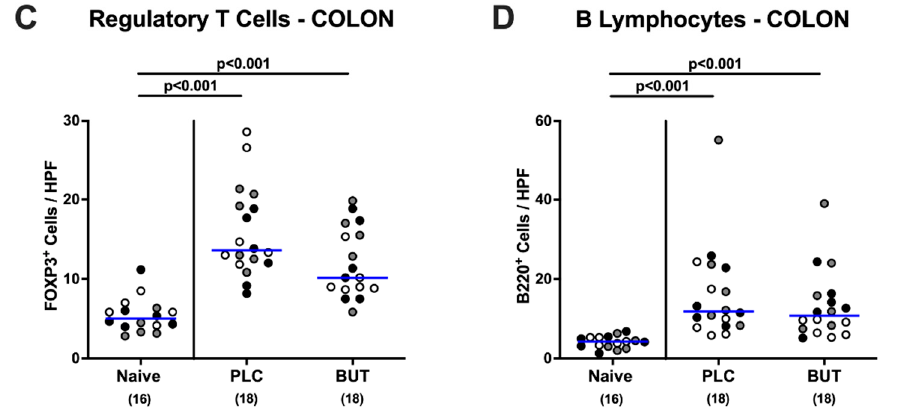
Figure 5. Immune cell populations in the colon upon butyrate treatment of C. jejuni mice. Following gut microbiota depletion IL-10 − / − mice were challenged with C. jejuni strain 81–176 by oral gavage on days 0 and 1. Starting from day 2 p.i., the animals were subjected to butyrate (BUT) or placebo (PLC) via the autoclaved tap water ad libitum. Naive mice served as uninfected and untreated controls. On day 6 p.i., ( A ) neutrophils, ( B ) T lymphocytes, ( C ) regulatory T cells, and ( D ) B lymphocytes were counted in the mucosa and lamina propria of immunohistochemically stained large intestinal paraffin sections (median counts from six high-power fields (HPF), 400-fold magnification). Differently colored circles indicate data from three individual experiments. Medians (blue bar), significance levels ( p values) evaluated by the ANOVA test with Tukey post-correction or by the Kruskal–Wallis test and Dunn’s post-correction, and the total numbers of included animals (parentheses) are shown.